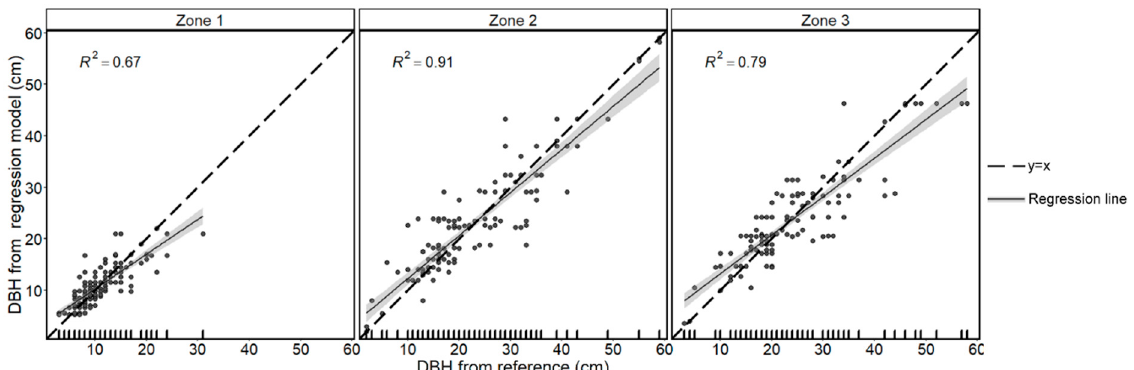
Figure 5. Comparison of DBH, estimated from the multivariate linear regression model with independent variables of height (H) and canopy area (A) in trees with high stand form.